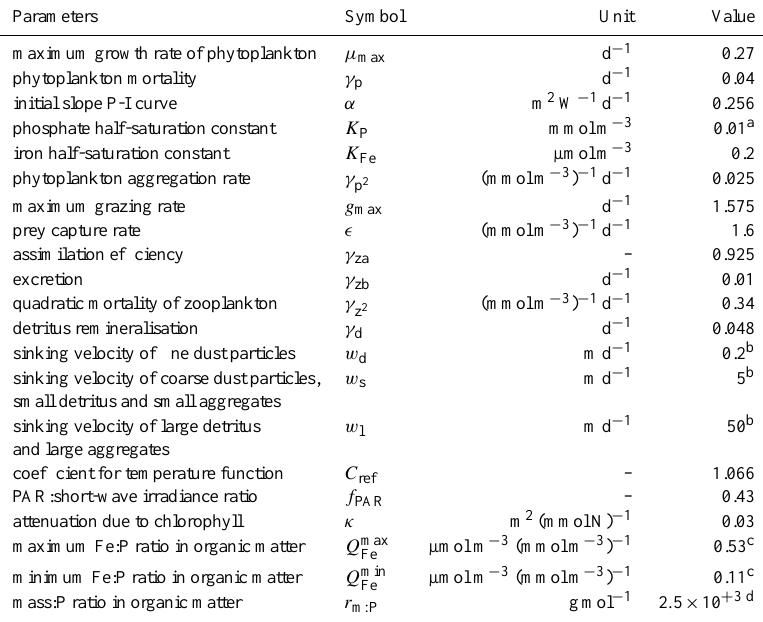
Table 1. Parameters in the biological model. Source of parameter values are shown as footnotes; other parameters are optimised for the North Atlantic by Schartau and Oschlies (2003a,b).